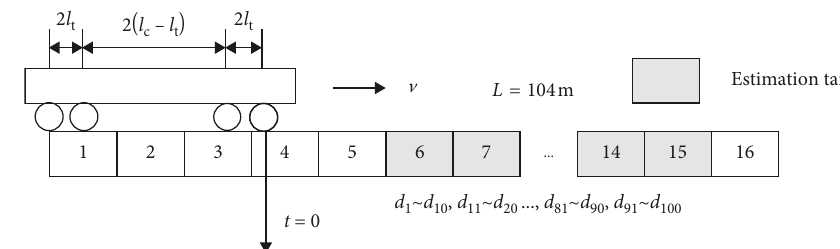
Figure 3: Schematic diagram of the overall model.